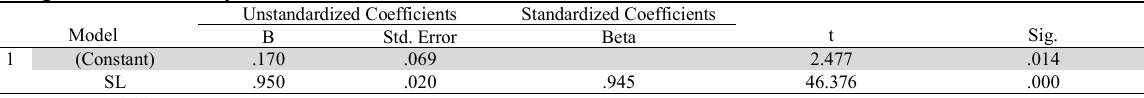
SL against JS – Analysis of Coefficients a